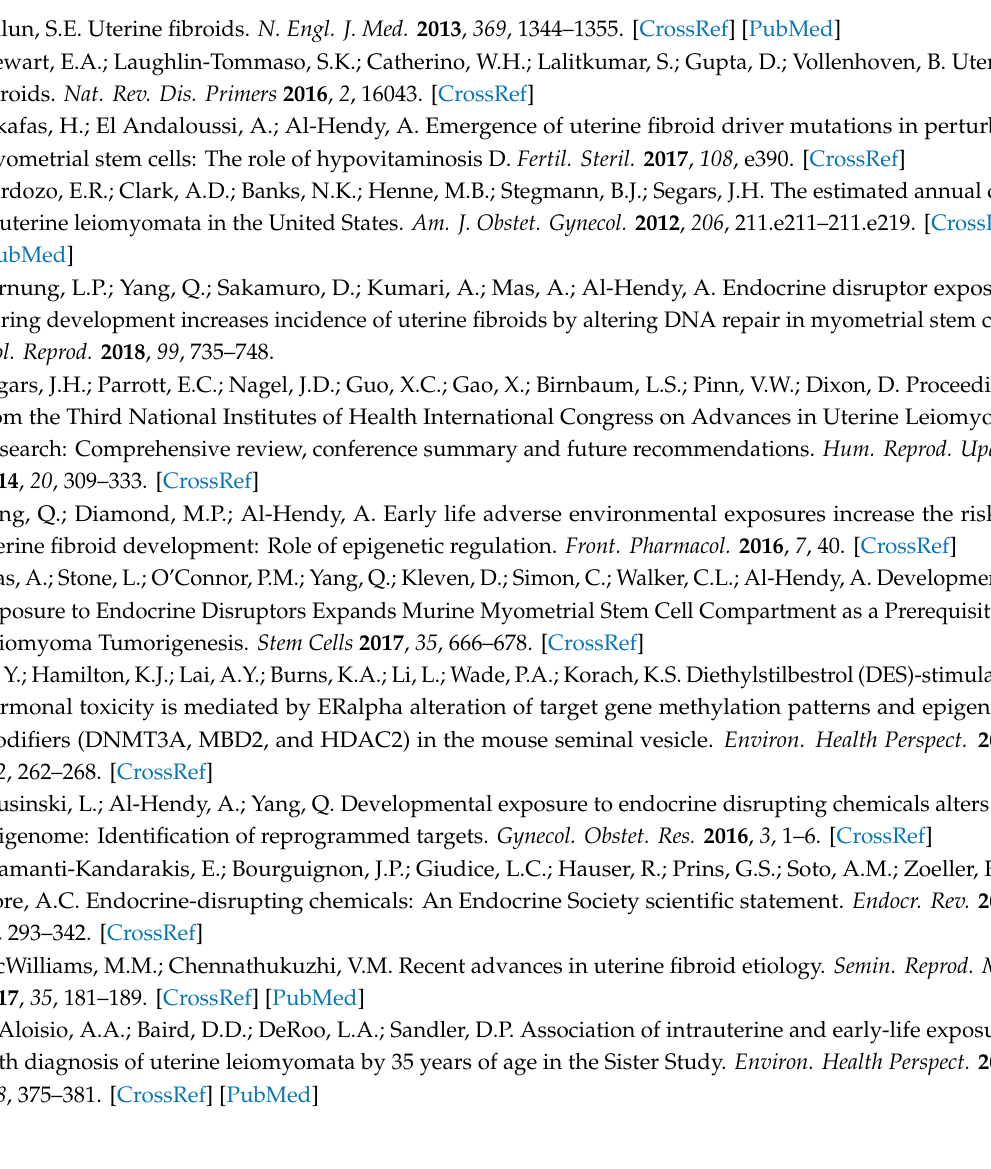
Figure S1: The animal model and experimental design, Figure S2: RNA expressions of DNA repair genes in VEH-MMSCs and DES-MMSCs with or without VitD3. Figure S3: Experimental design of VitD3 e ff ect on DNA damage repair in DES-MMSACs with or without classic DNA damage inducers. Figure S4: The e ff ect of VitD3 on DES-MMSCs